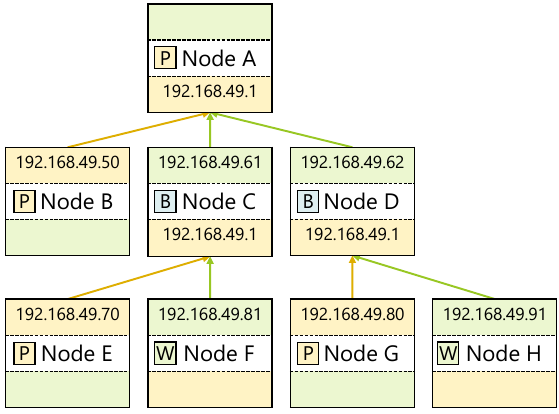
Figure 3. Example of topology construction. The IP address assigned to the P2P-side NIC of GO is fixed at 192.168.49.1/24, while the other IP addresses are randomly